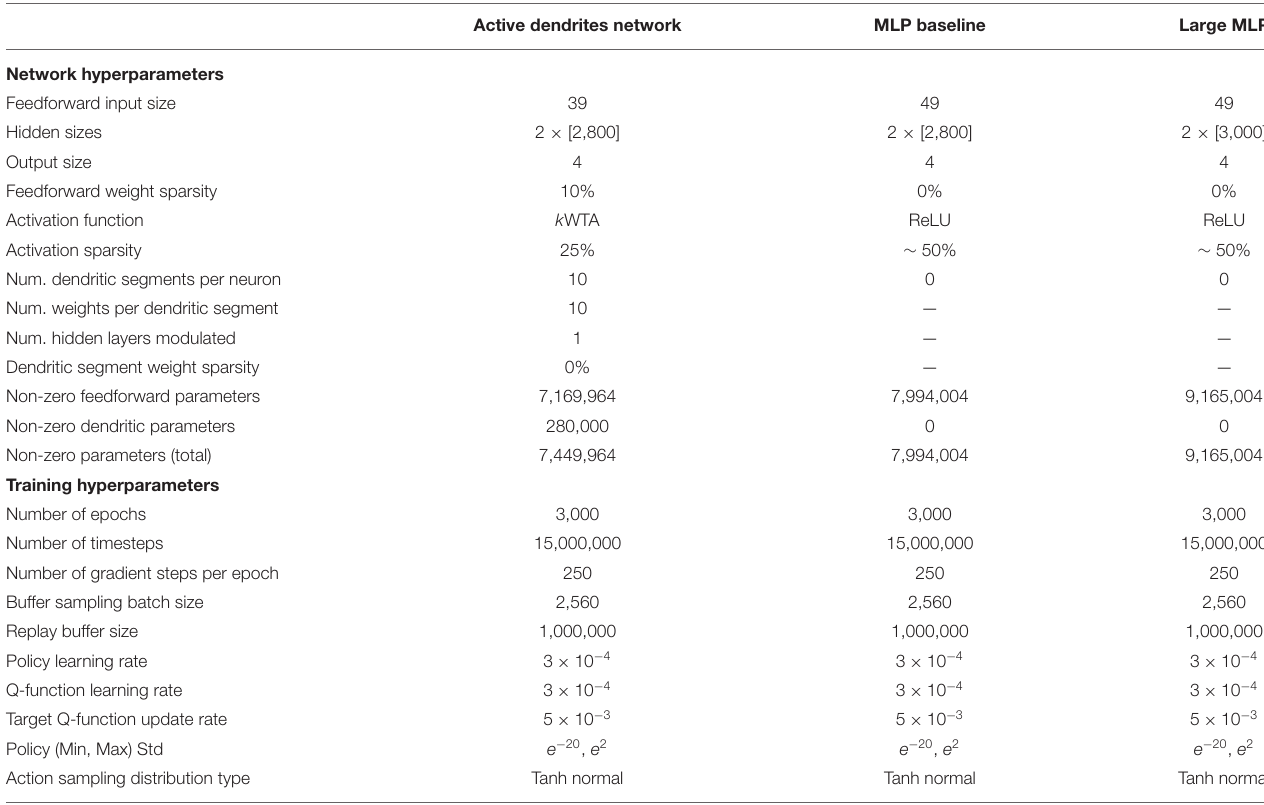
TABLE 2 | The hyperparameters for each multi-task RL